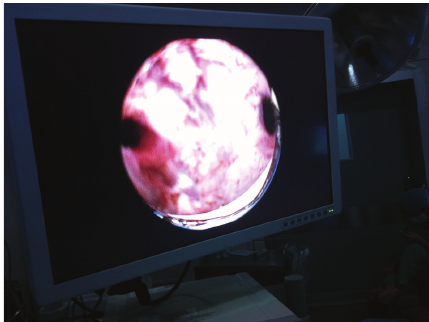
Figure 3: Opened ejaculatory ducts after transurethral plasmaki- netic resection.